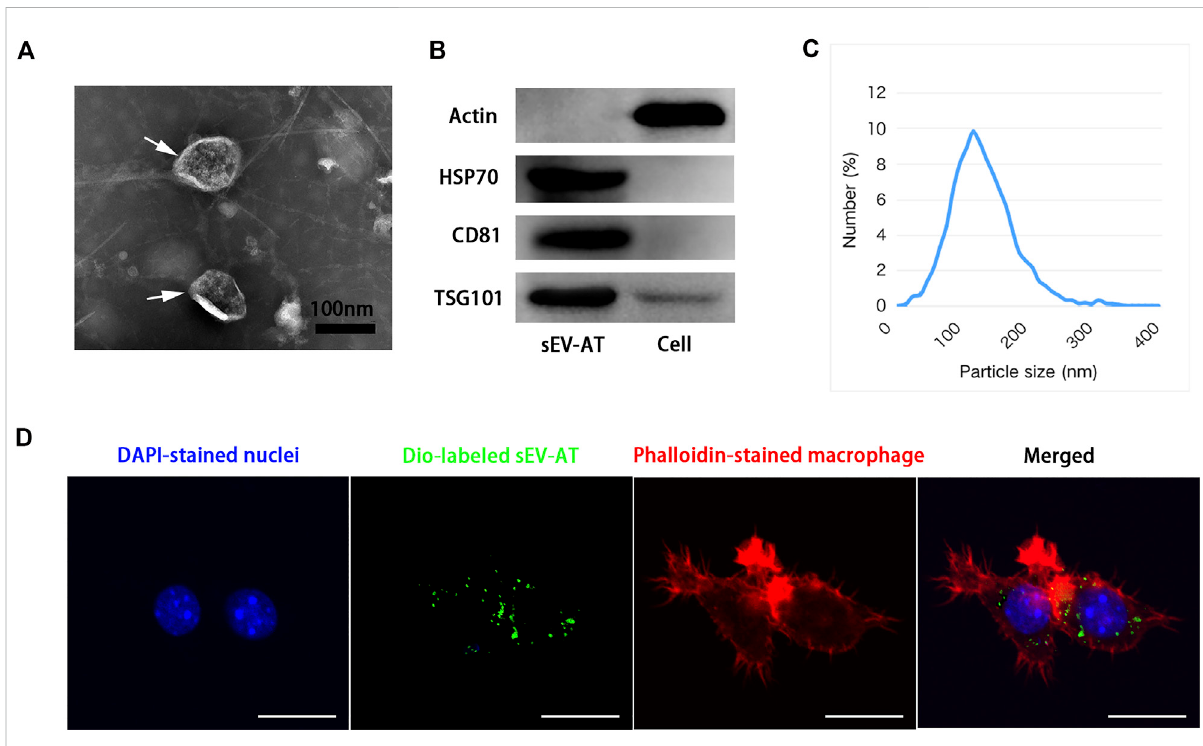
FIGURE 1 Characterization of sEV-AT. (A) Representative images of sEV-AT with transmission electron microscopy. The white arrows pointed out the sEV-AT. Scale bar = 100 nm. (B) Western blot analysis of exosomal makers, HSP70, CD81, and TSG101. Actin was cellular a protein as a control. (C) The particle size distribution of sEV-AT was measured by ZataView analysis. (D) Uptake analysis of sEV-AT by macrophages (blue: DAPI-stained nuclei; green: Dio-labeled sEV-AT; red: phalloidin-stained macrophage). Scale bar = 10